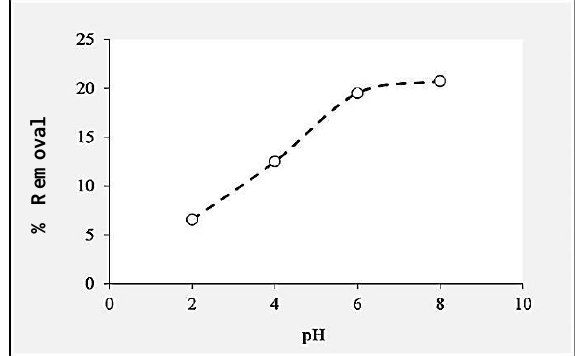
Figure 5. Effect of pH on ferrous ion removal Effect of grafted gum dose